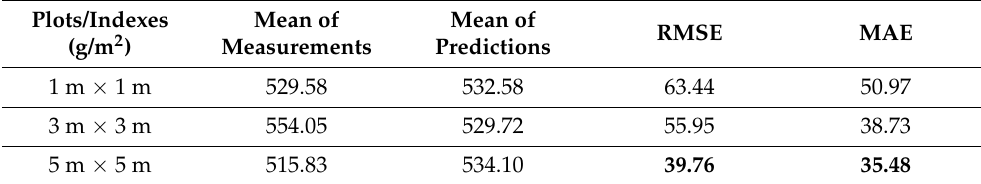
Table 3. Comparison of yield prediction accuracy of the GPR model constructed by combining the ESCVIs at the flowering and filling stages in different sized plots. Boldface represents the best